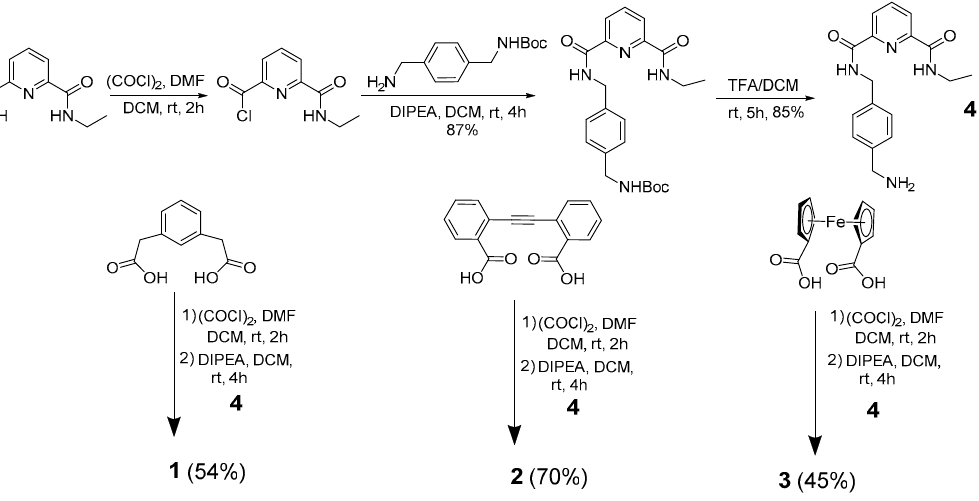
Figure 2. Synthetic route to receptors 1 , 2 , and 3 .